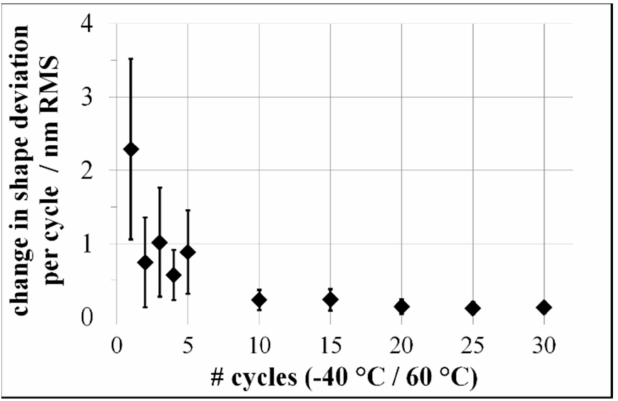
Figure 7. Change in shape deviation of mirrors made of Al-42Si with respect to numbers of environ- mental thermal cycles between − 40 ◦ C and 60 ◦